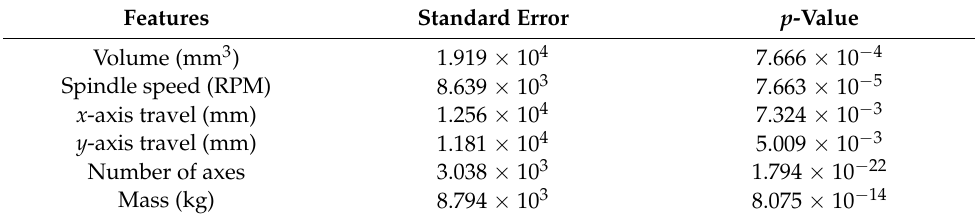
Table 6. Standard error and p -values for Haas cost (price) model (found in Equation (2)).